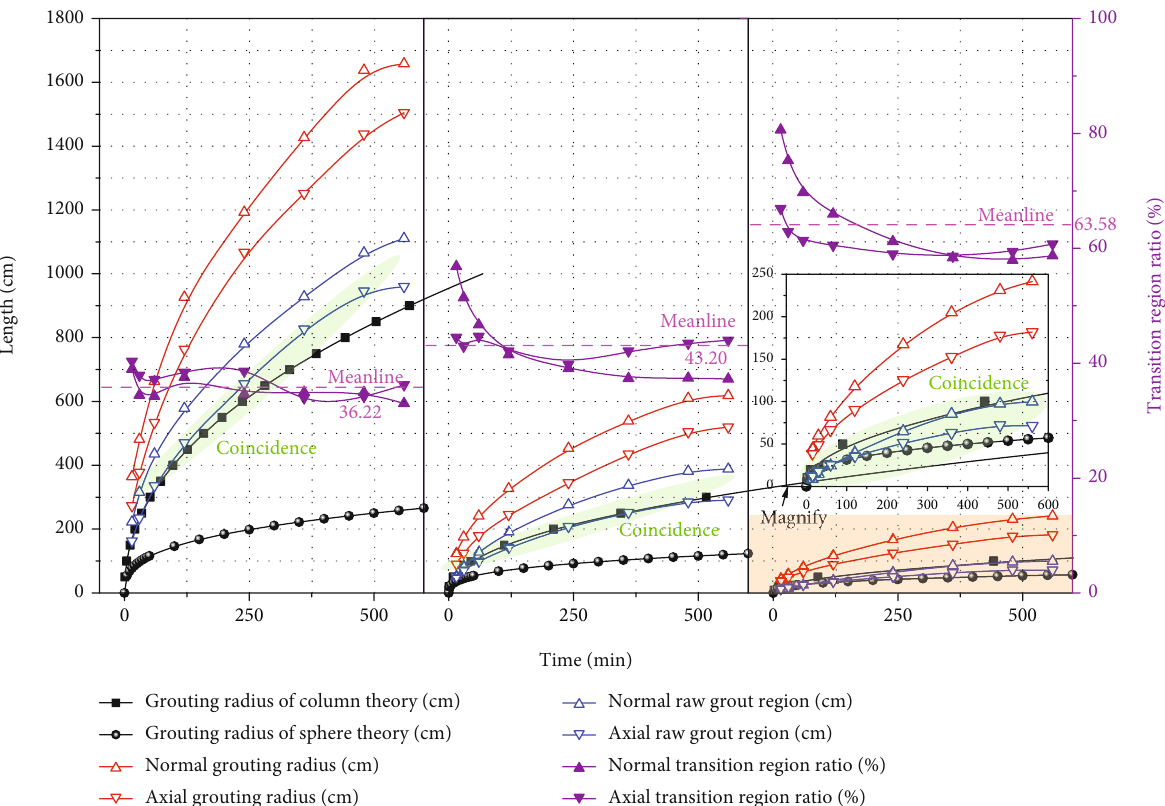
Figure 7: Comparisons between numerical simulation and theoretical calculation of grouting radius under di ff erent initial